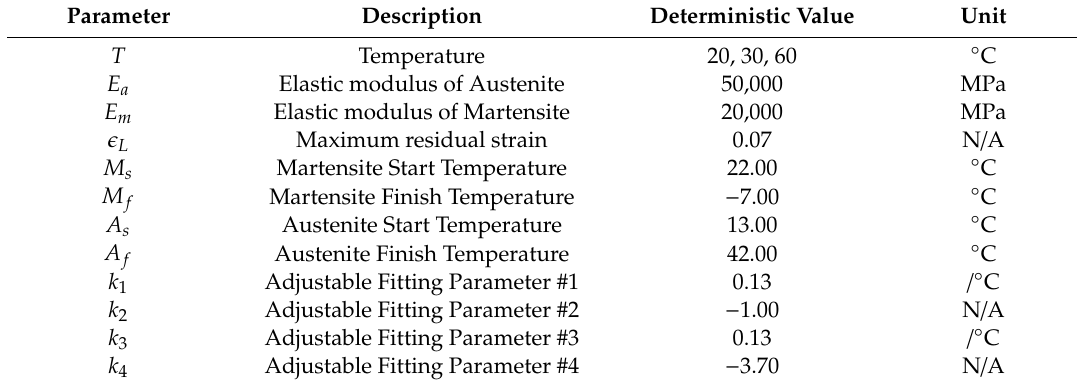
Table 1. Material Properties Ivshin et al. [58].